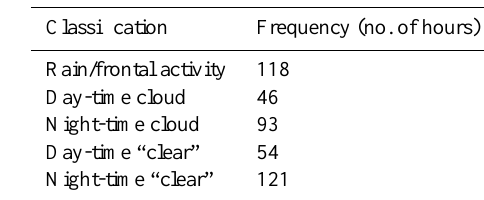
Table 1. Frequency of periods of rain, and cloud cover estimated from lidar data by day and